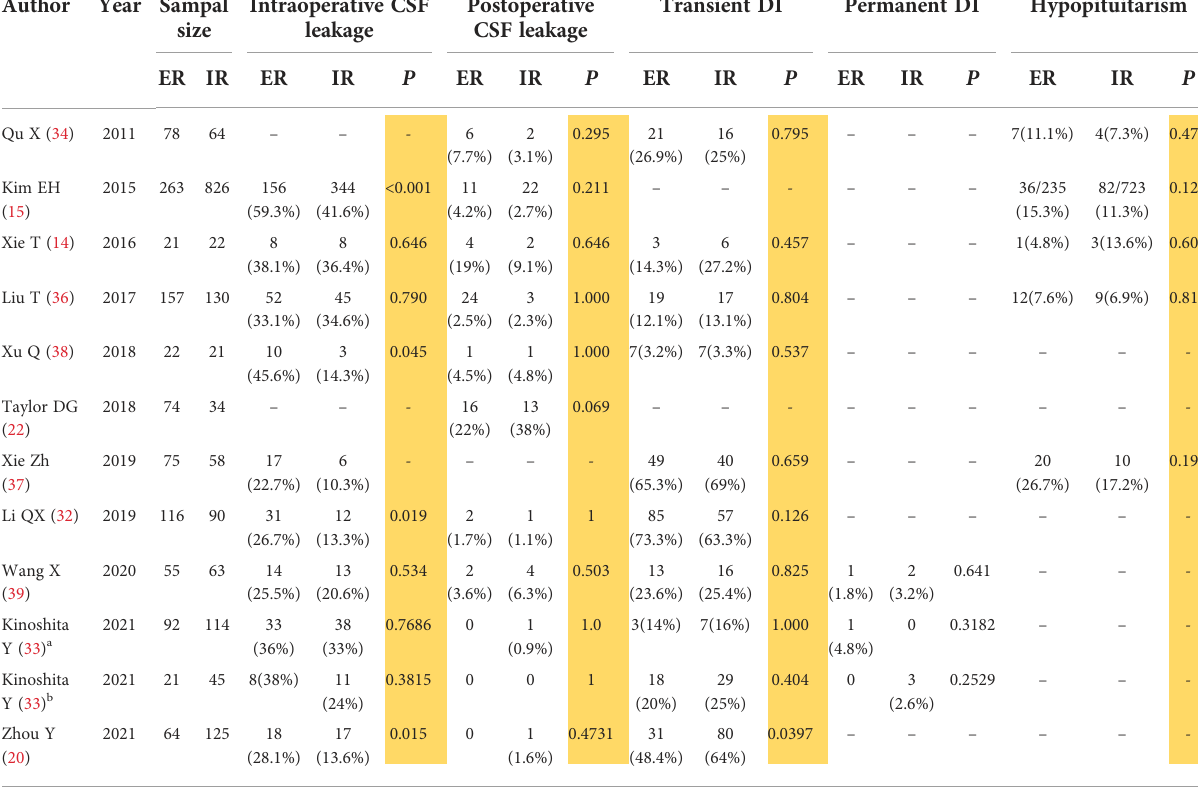
TABLE 2 ER and the complications after operations,such as Intraoperative CSF leakage,Postoperative CSF leakage,Transient and Permanent DI, Hypopituitarism.